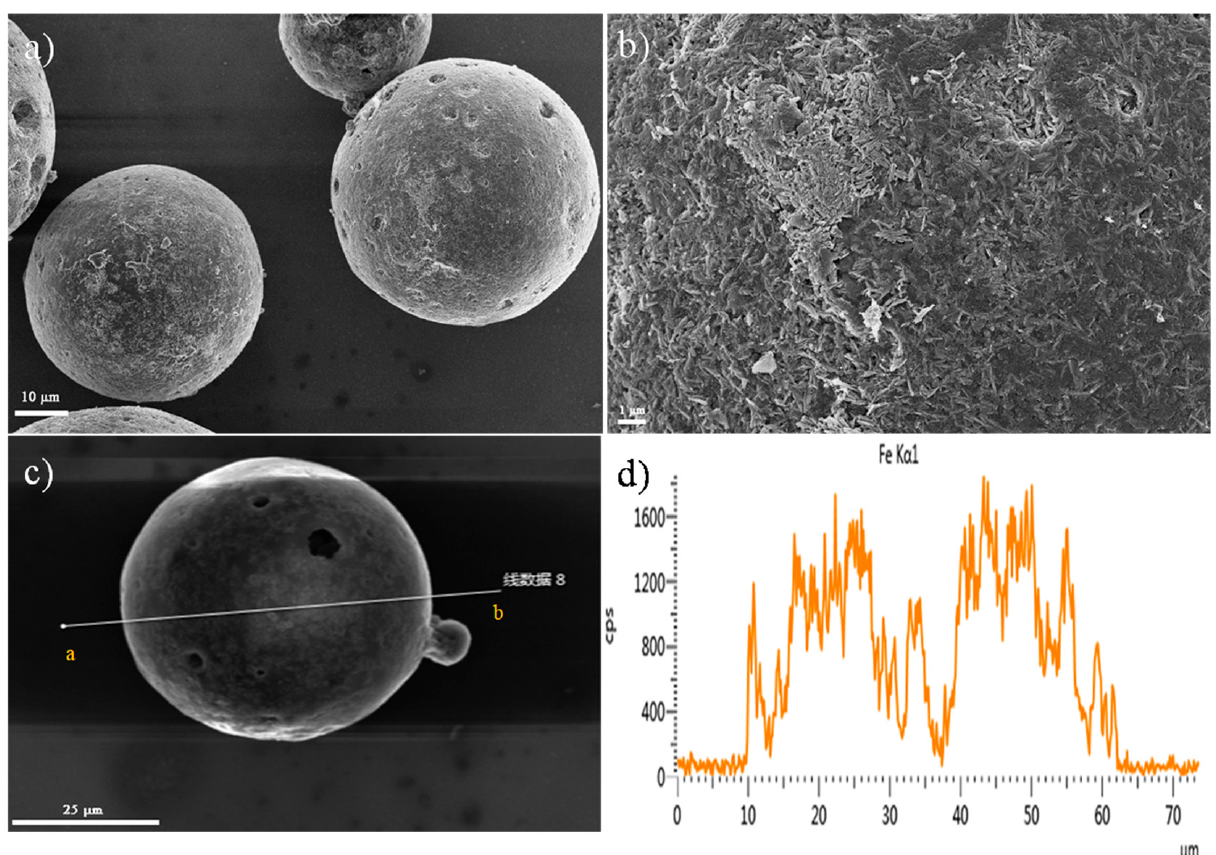
Figure 3. ( a ) SEM image of MAER, ( b ) SEM image of MAER in high magnification, ( c ) EDS element line-scanning of MAER, and ( d ) the Fe element signal of image ( c ) along a line to b.